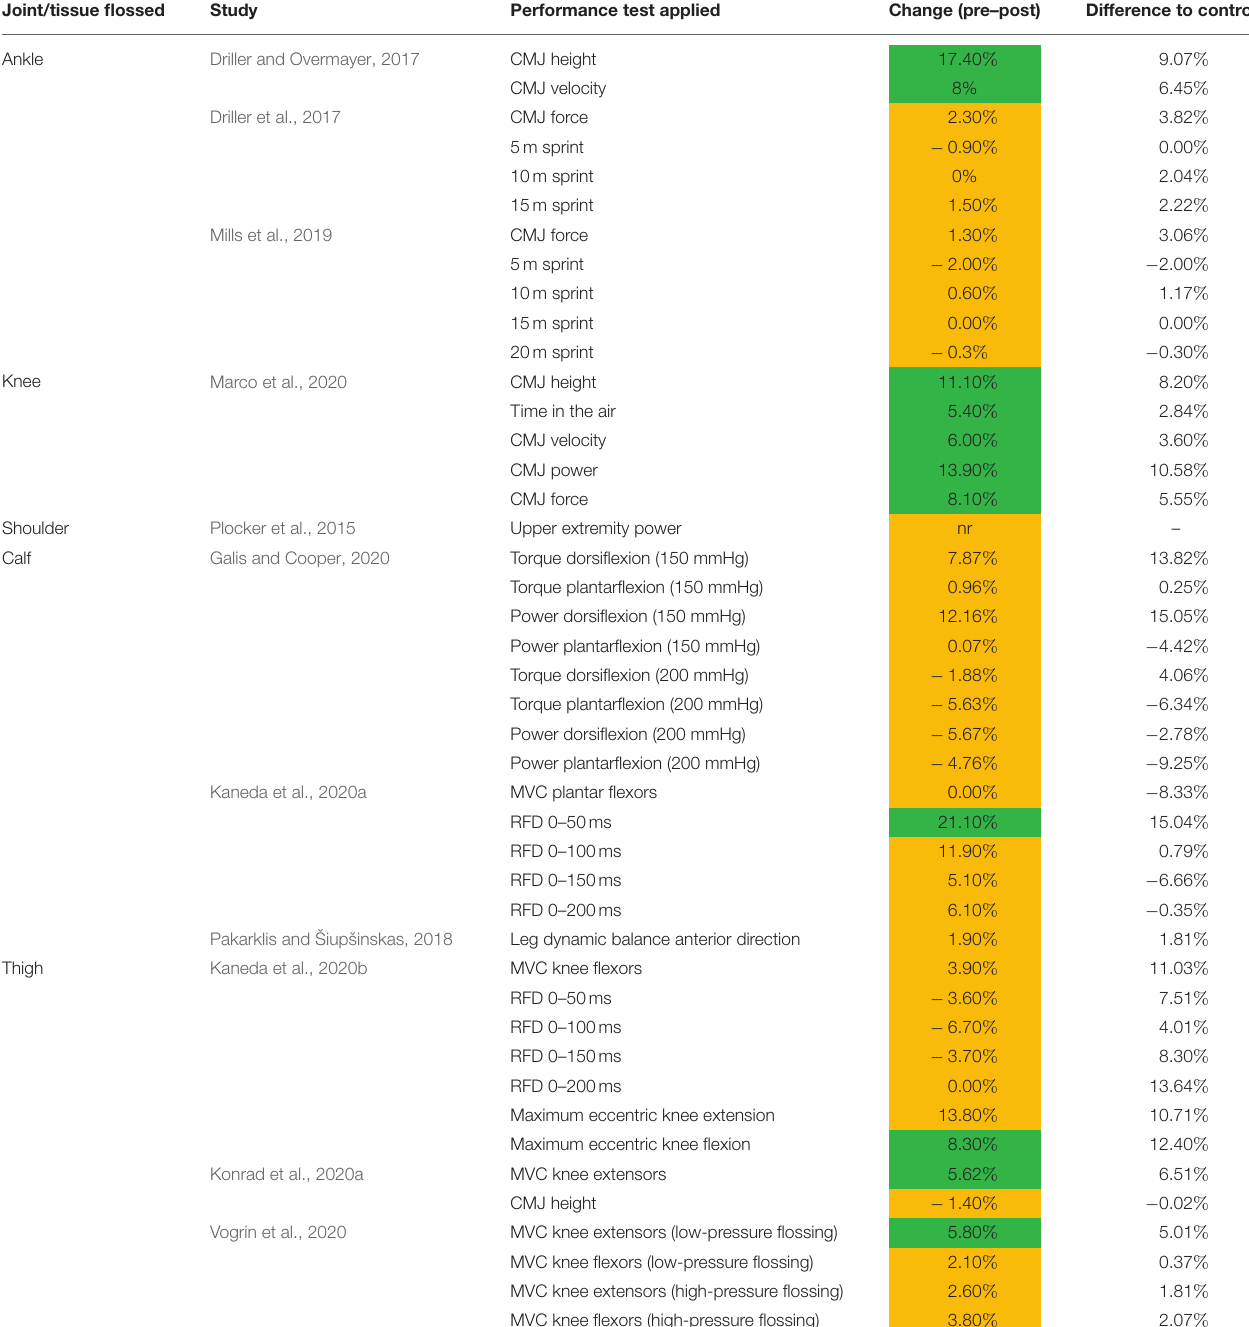
TABLE 3 | Summary of the results of the studies which investigated the acute effect of flossing on performance parameters. Joint/tissue